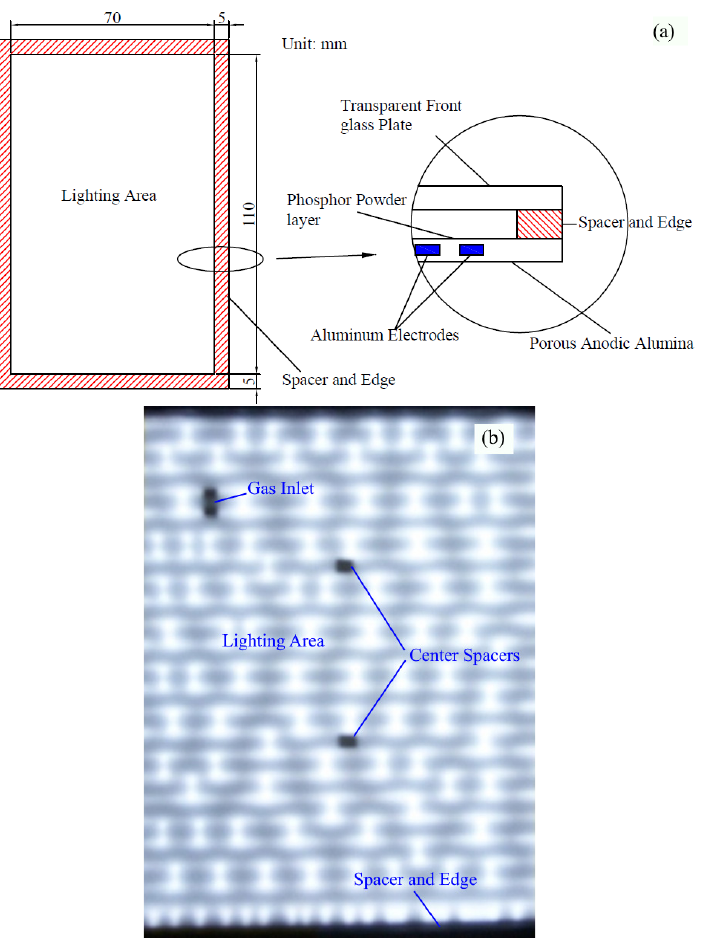
Figure 6. Structure ( a ) and photograph image ( b ) of coplanar capillary plasma electrode discharge flat-panel lamps.